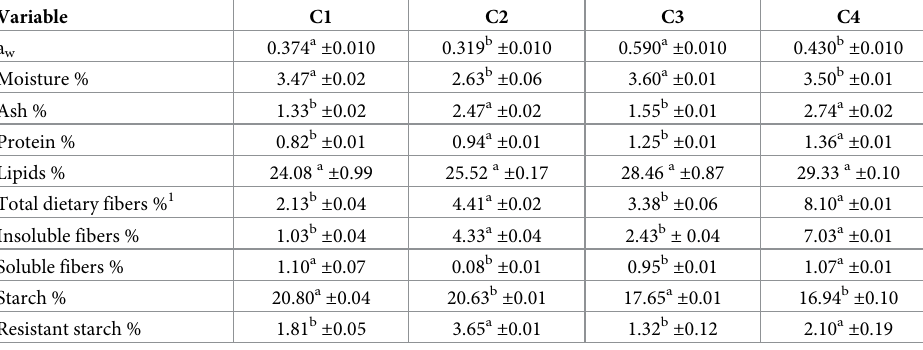
Table 2. Physicochemical properties of the functional cookies.